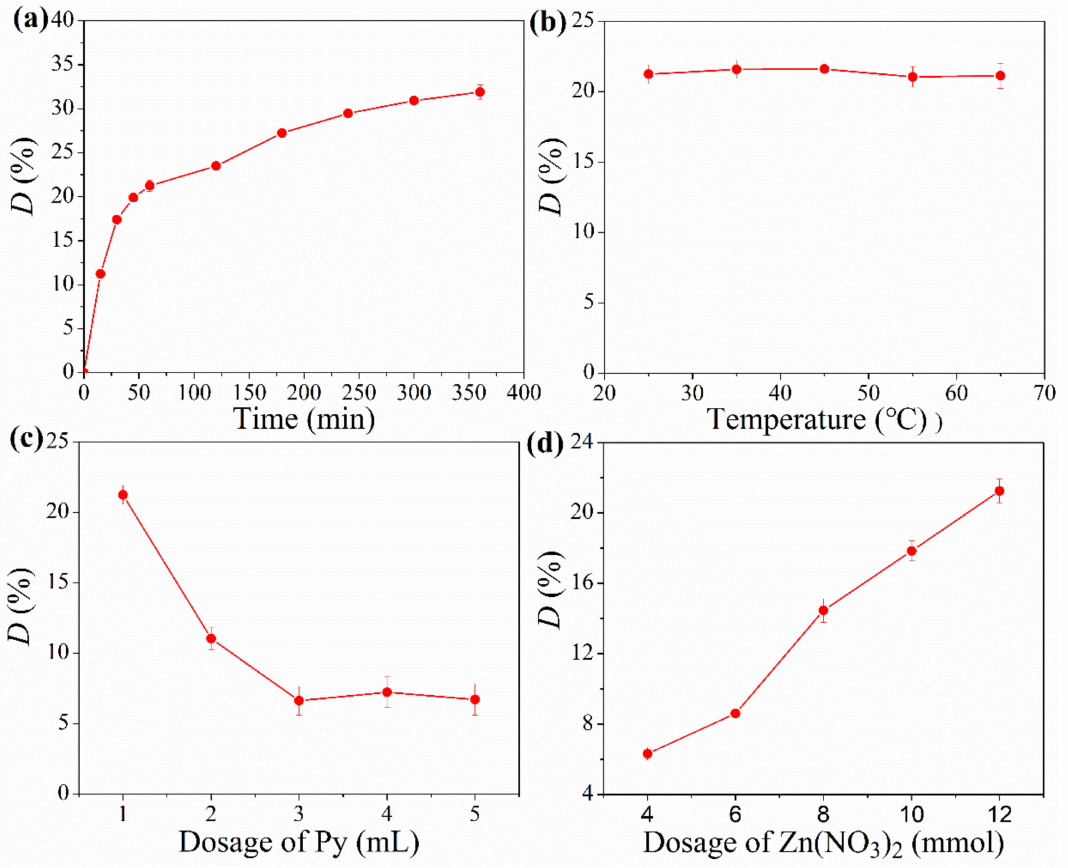
Figure 2. Effect of time ( a ), temperature ( b ), dosages of Py ( c ) and Zn(NO 3 ) 2 ( d ) on ZIF-8 deposition. Process conditions: ( a ) 25 ◦ C, Py 1 mL, Zn(NO 3 ) 2 12 mmol; ( b ) Py 1 mL, Zn(NO 3 ) 2 12 mmol, 1 h; ( c ) 25 ◦ C, Zn(NO 3 ) 2 12 mmol, 1 h; ( d ) 25 ◦ C, Py 1 mL, 1